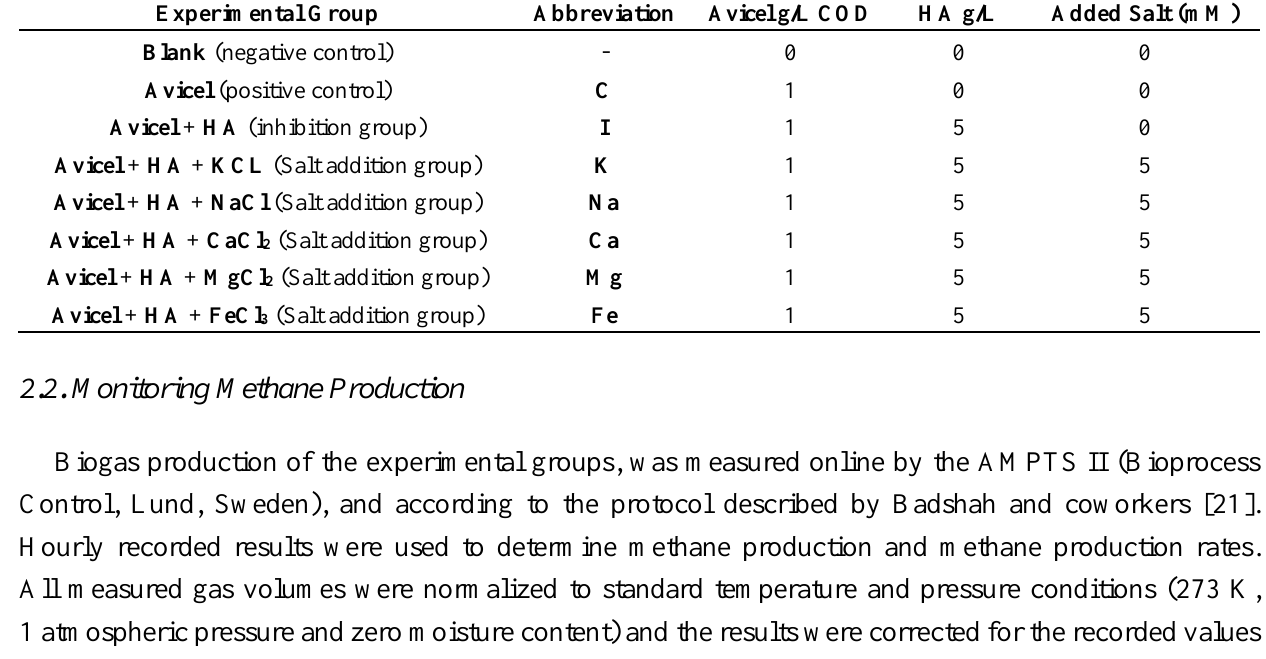
Table 1. Summary of the experimental set-up and abbreviations that are used in the text. Experimental